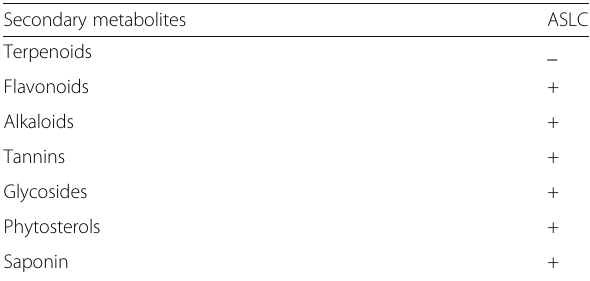
Table 6 Preliminary phytochemical screening of the aqueous stem extract of L.